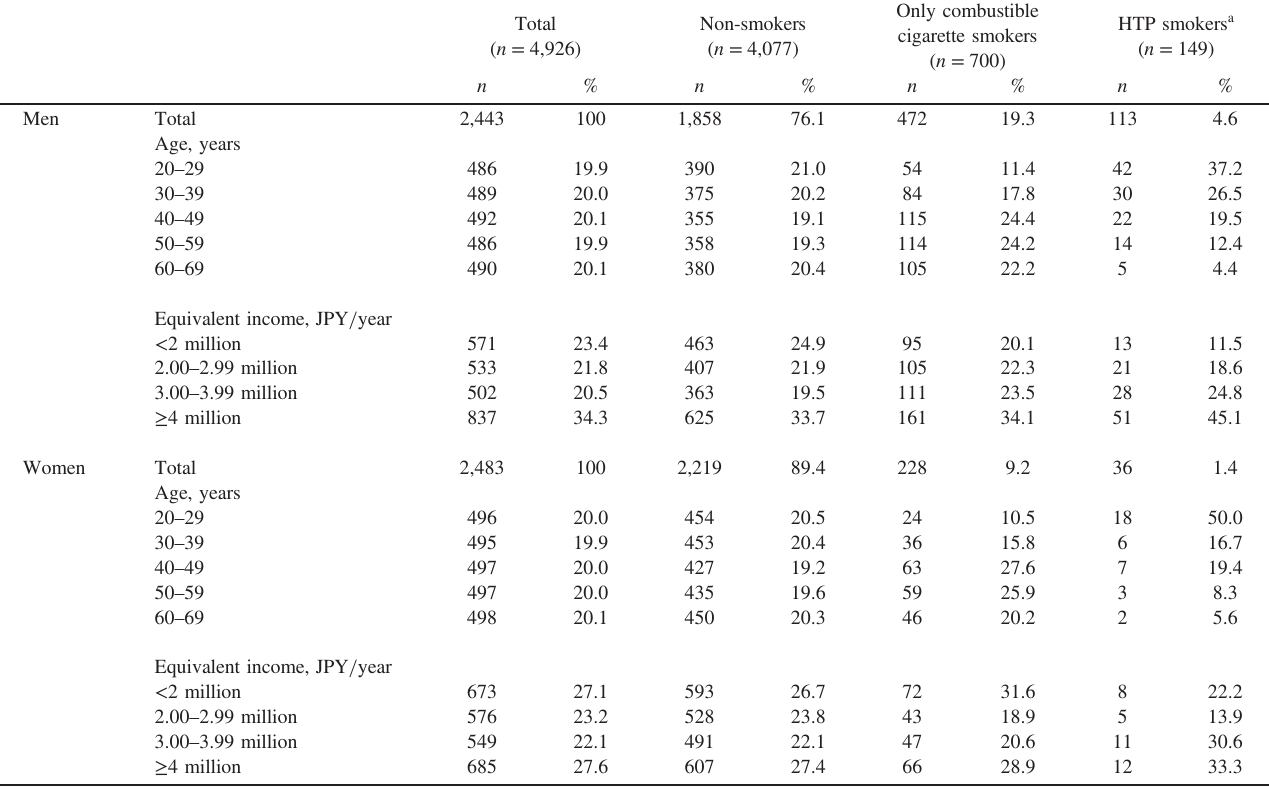
Table 1. Basic characteristics of participants according to smoking status and type of tobacco